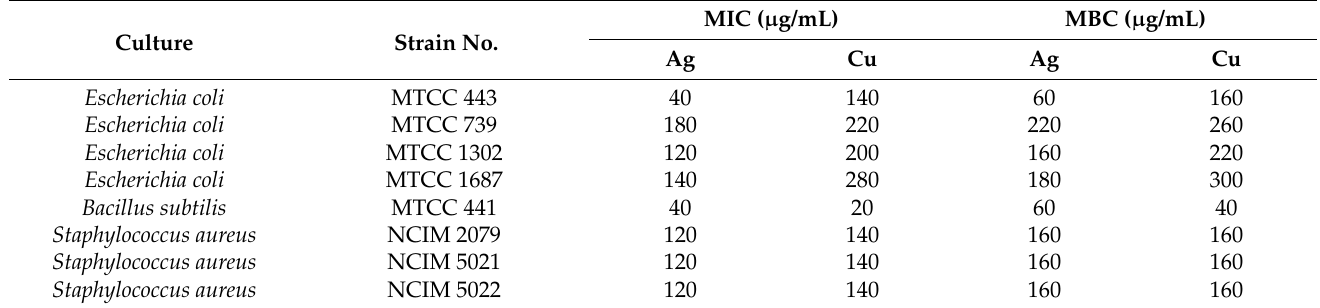
Table 6. Antimicrobial effect of Ag and Co nanoparticles on various microorganisms [68]. MIC ( µ g/mL) MBC ( µ g/mL) Culture Strain No. Ag Cu Ag